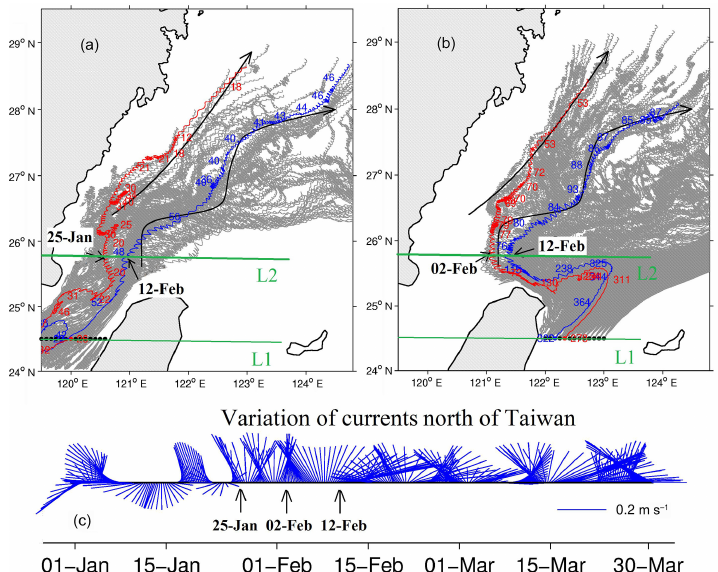
Figure 15. Traces of TSC water (a) and Kuroshio water (b) in winter, with the variation of surface currents north of Taiwan (c) . The green lines L1 and L2 indicate the starting latitude of the tracers (24.5 ◦ N) and the latitude which is representative for synoptic fluctuations north of Taiwan (25.8 ◦ N), respectively. The black dots represent the release locations of tracers originated from line L1. The gray lines show the entire trajectories of the tracers. The red lines and blue lines are selected trajectories, which are close to the inshore branch and offshore branch, respectively. The dates show the times when selected tracers cross the latitude indicated by line L2. The numbers are the depths of the tracers, which are labeled at an interval of 6 days. The two black arrows represent the two TWC branches.